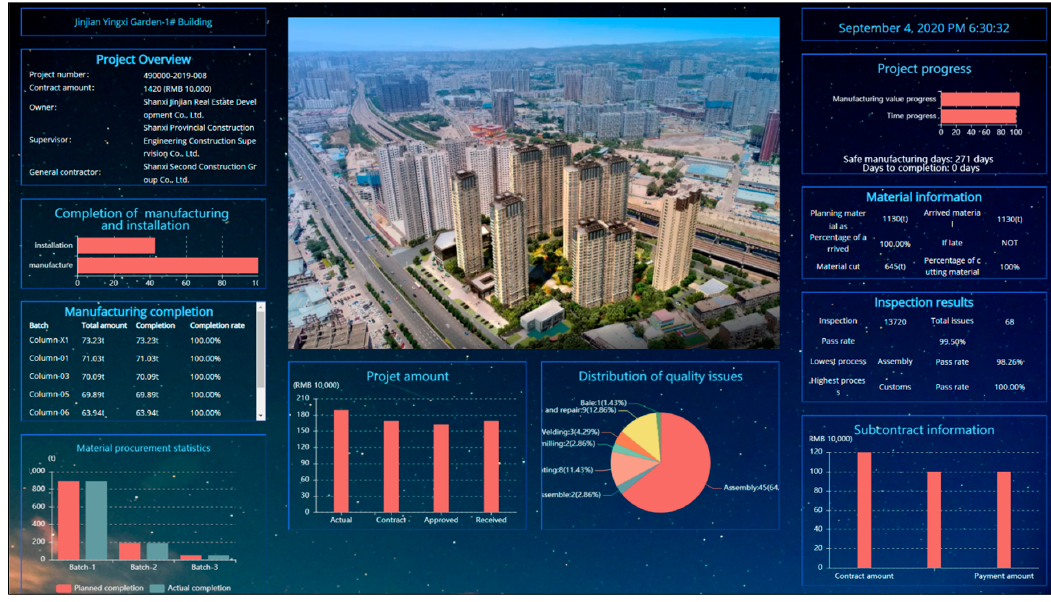
Figure 7. The main page of the BIM platform.